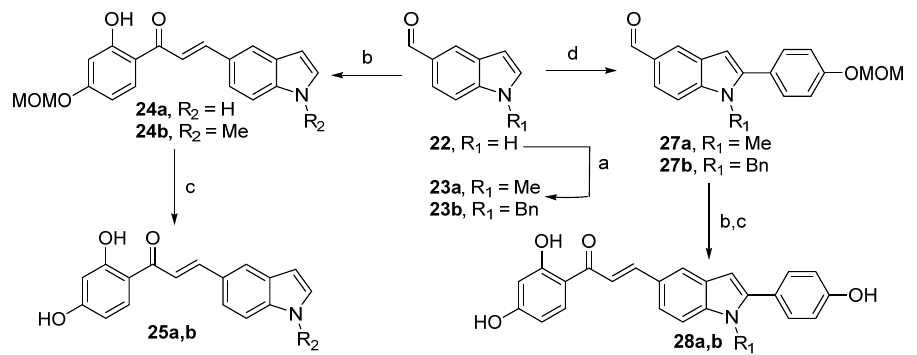
Table 2. Activity of compounds 1 , 16 – 18 , 21a , b , 25a , b , 28a , b , 29 and of reference compound am- photericin B against L. infantum